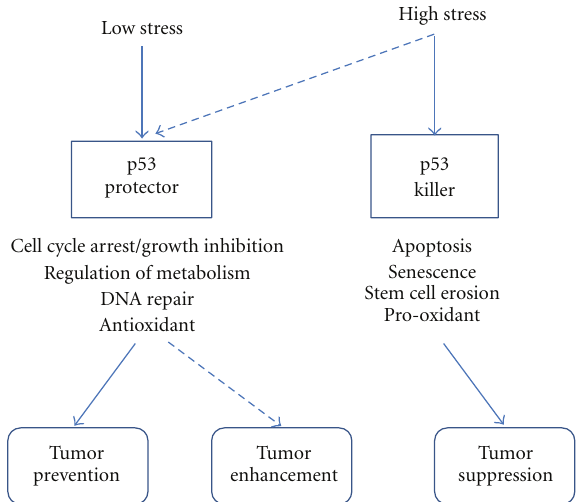
Figure 1: Vousden and Prives [2] proposed a model of the dual mechanism of p53 function in tumors. The result of p53 activation depends on multiple variables. In this model, the p53 response to low stress results in cell cycle arrest, growth inhibition, DNA repair, and so on. This response enables cells to restore the damage induced by the cellular stress. But when the cells receive high stress that cannot be restored, p53 acts as killer that can induce apoptosis or senescence, preventing proliferation of defective cells. If p53 mistakenly responds as a protector when cells receive a high stress that cannot be repaired, the cells keep the genetic damage, which can lead to or contribute to cancer progression (dotted